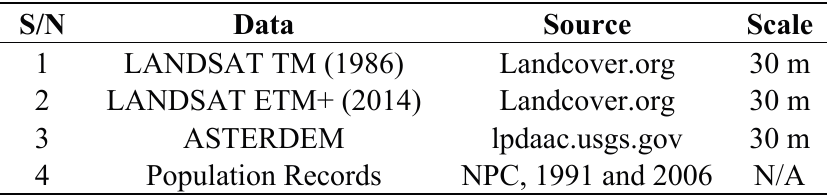
Table 1. Data sources and